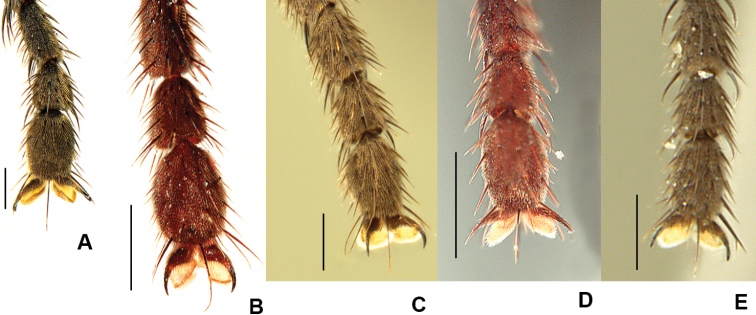
Female fore tarsomeres 3–5 AD.
pontiBD.
aldrichiCD.
similisDD.
profrontalisED.
minor. Scale bars: 0.25 mm.